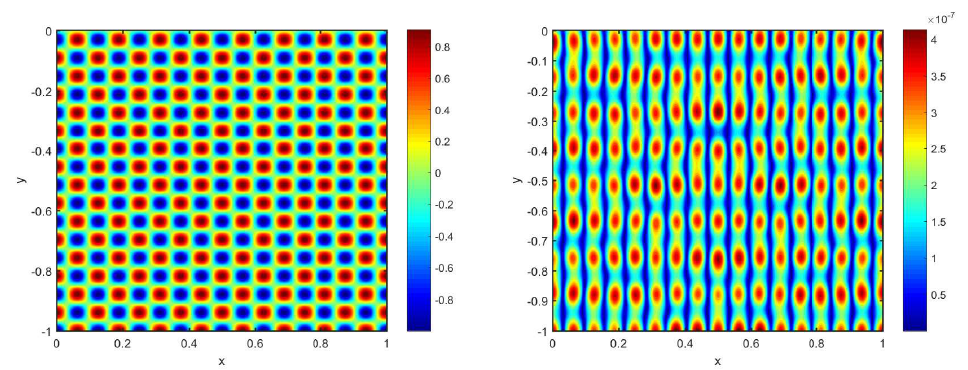
Figure 3. The real part of the numerical solution ( left ) and the absolute error plot ( right ) for the empty cavity with k 0 = 16 π m − 1 , h = 1/1024 m.